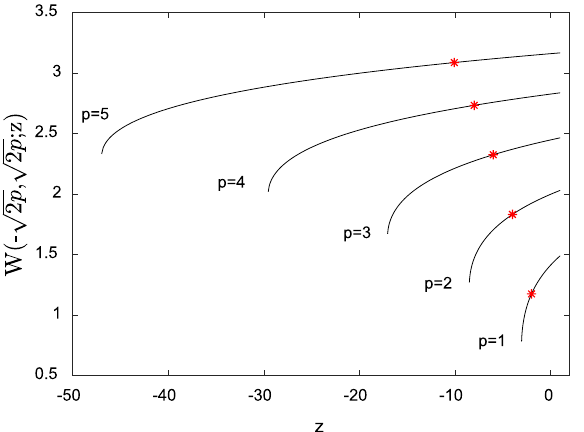
Figure 2. The generalized Lambert W function